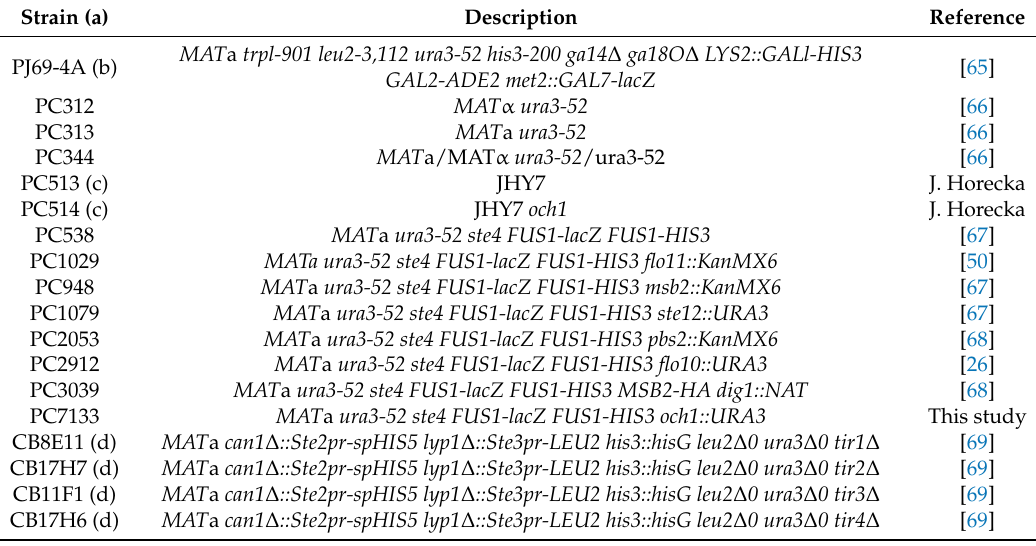
Table 1. Saccharomyces cerevisiae strains used in the